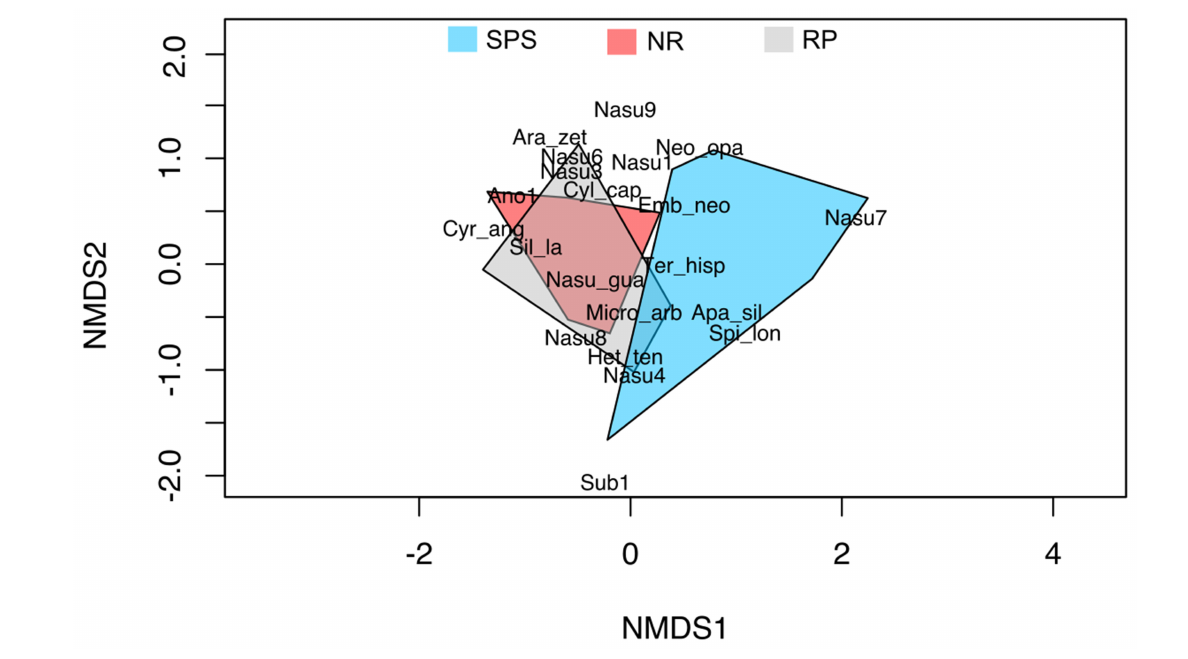
FIGURE 2 | Nonmetric multidimensional scaling (NMDS) composition of termite species collected in natural regeneration (RN), silvopastoral systems (SPS), and rubber plantations (RP) in Colombian Amazon region. This ordination analysis was calculated from the Bray–Curtis dissimilarity index’s (Stress = 0.07). Ano1, Anoplotermes sp. 1; Apa_sil, Aparatermes silvestrii ; Ara_zet, Araujotermes zeteki ; Cyl_cap, Cylindrotermes capixaba ; Cyr_ang, Cyrilliotermes angulariceps ; Emb_neo, Embiratermes neotenicus ; Het_ten, Heterotermes tenuis ; Micro_arb, Microcerotermes arboreus ; Nasu_gua, Nasutitermes guayanae ; Nasu1, Nasutitermes sp. 1; Nasu3, Nasutitermes sp. 3; Nasu4, Nasutitermes sp. 4; Nasu6, Nasutitermes sp. 6; Nasu7, Nasutitermes sp. 7; Nasu8, Nasutitermes sp. 8; Nasu9, Nasutitermes sp. 9; Sil_la, Silvestritermes cf. lanei ; Spi_lon, Spinitermes longiceps ; Sub1, Subulitermes sp. 1; Ter_hisp, Termes hispaniolae